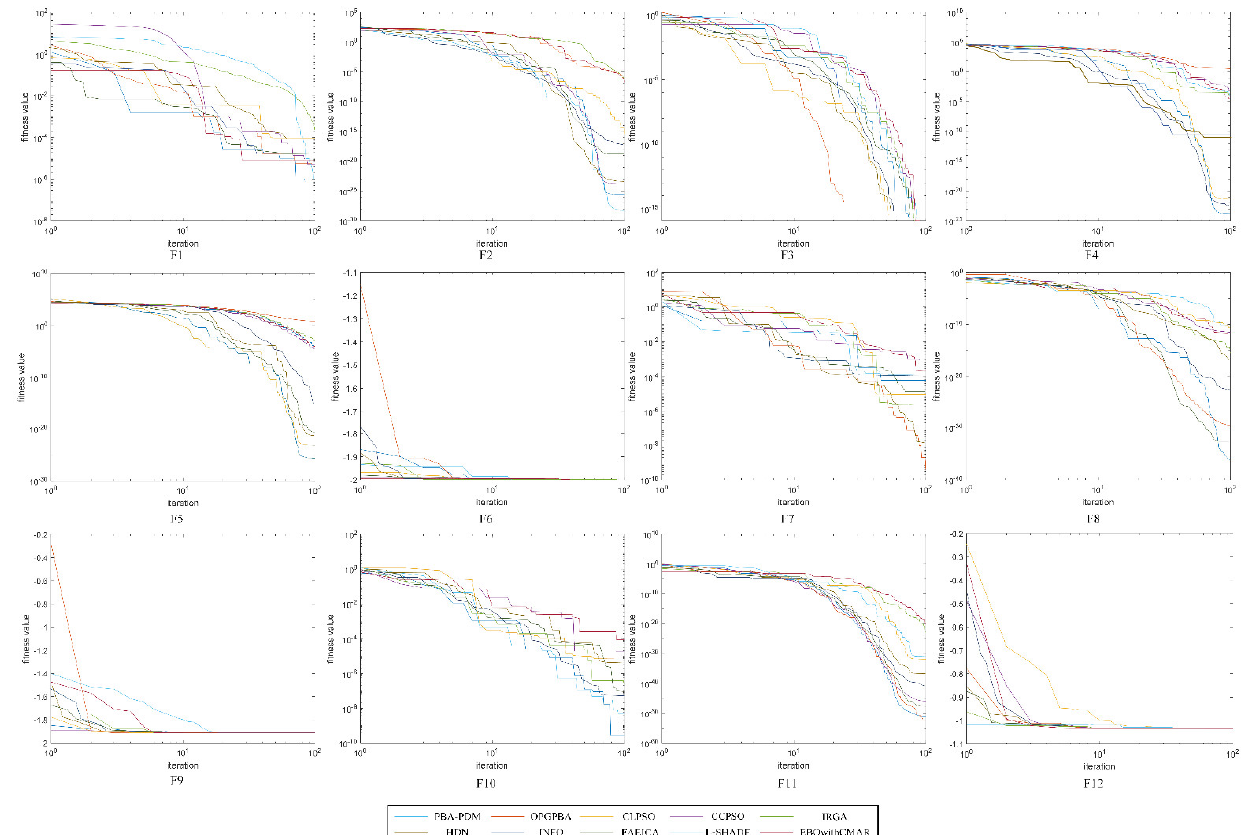
Figure 8. Convergence curves of the unimodal function.